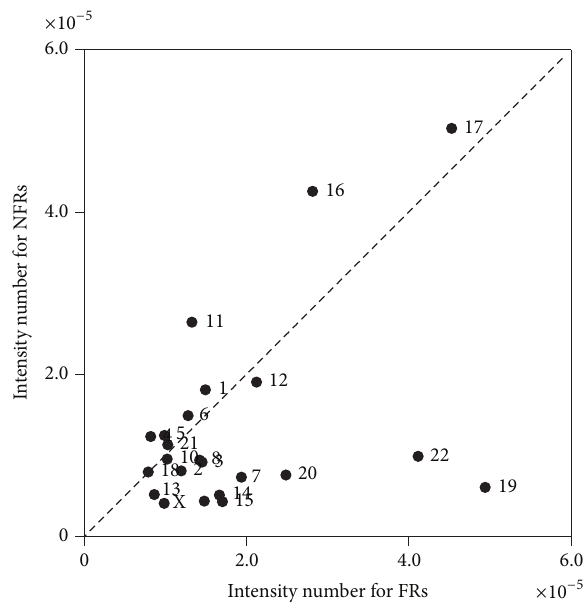
Figure 2: Integration of HIV-1 isolated from Jurkat T cells in FRs versus NFRs. Graphical representation of the results for the intensity number. Eachpointrepresentsachromosomewhosecoordinatesare the (𝑥, 𝑦) pairs obtained in the measure calculations. The statistical analysisindicatesthatthevirusintegrateswithequalintensityinFRs and in NFRs (Sign test, 𝑝 value: 0.202, and Wilcoxon test, 𝑇 obs : 82; 𝑇 critic :